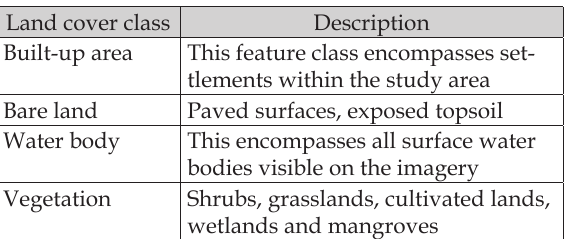
Table 1. Description of the land cover categories used in the